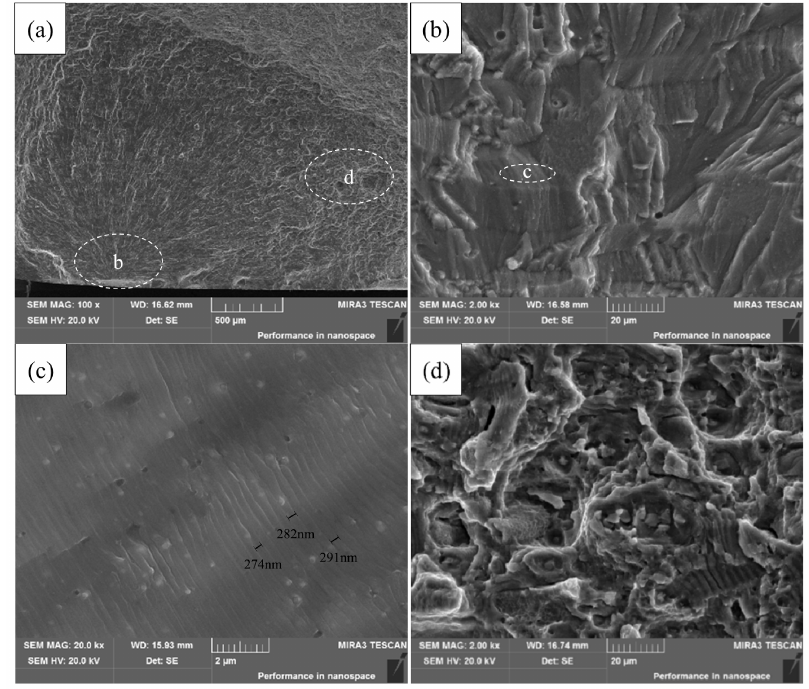
Figure 6. The fatigue fracture surfaces of Al-Cu-Mg alloy under 180 MPa after 12 h creep aging at 180 ◦ C: ( a ) full view; ( b ) fracture nucleation; ( c ) stable fatigue crack growth; ( d ) final fracture